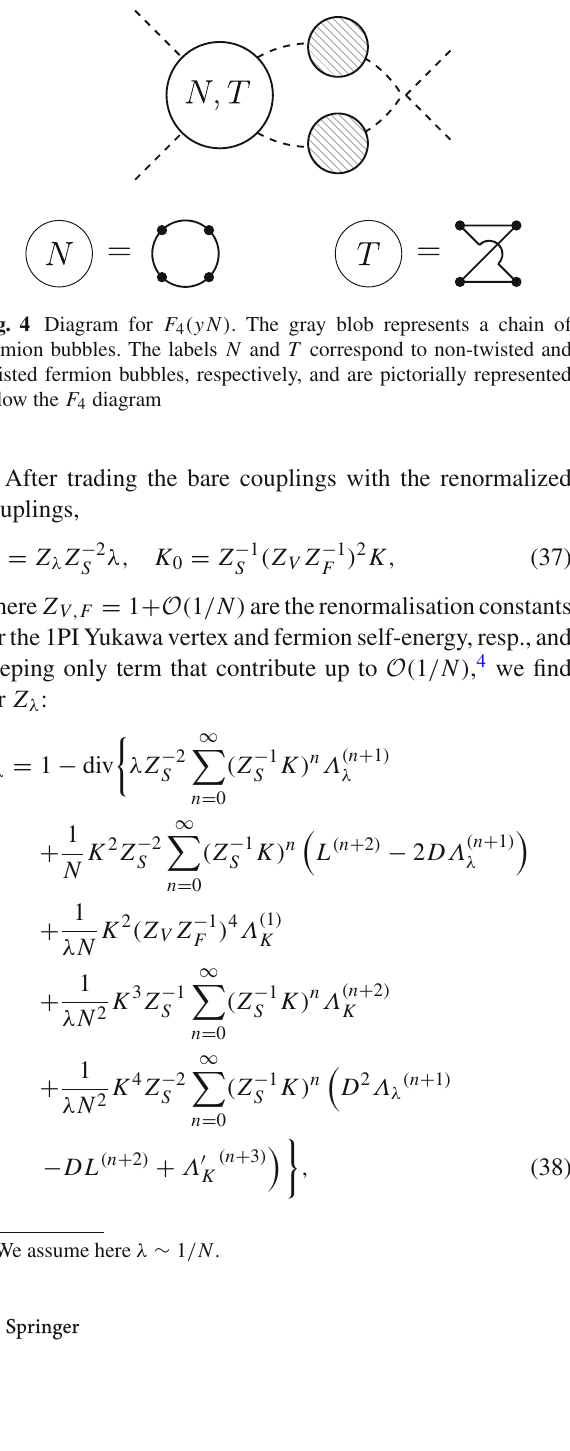
Fig. 3 Diagram for F 3 ( yN ) . The gray blob represents a chain of fermion bubbles